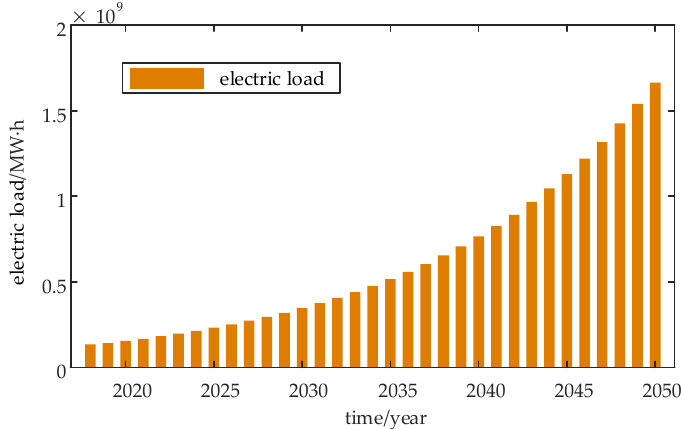
Energies 2022 , 15 , x FOR PEER REVIEW Figure 6. Forecasted annual electrical load from 2020 to 2050. Figure 6. Forecasted annual electrical load from 2020 to 2050.